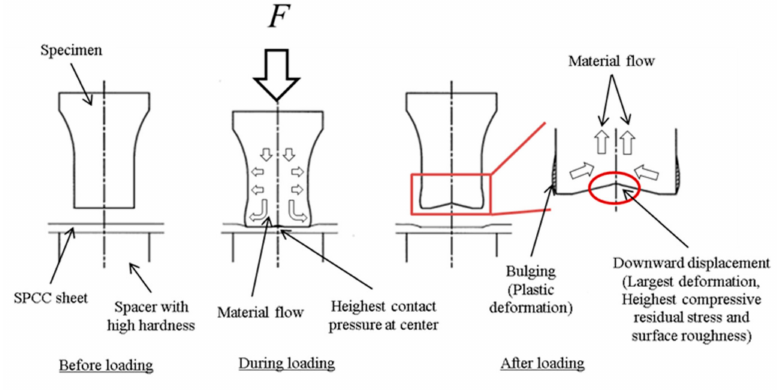
Figure 18. Schematic of the specimen deformation during the